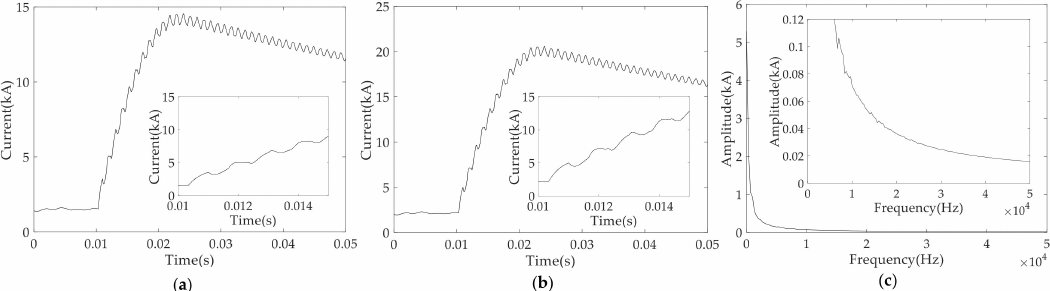
Figure 4. MMC-HVDC system PPF characteristics. ( a ) Current waveform; ( b ) current line mode component waveform; ( c ) spectrum